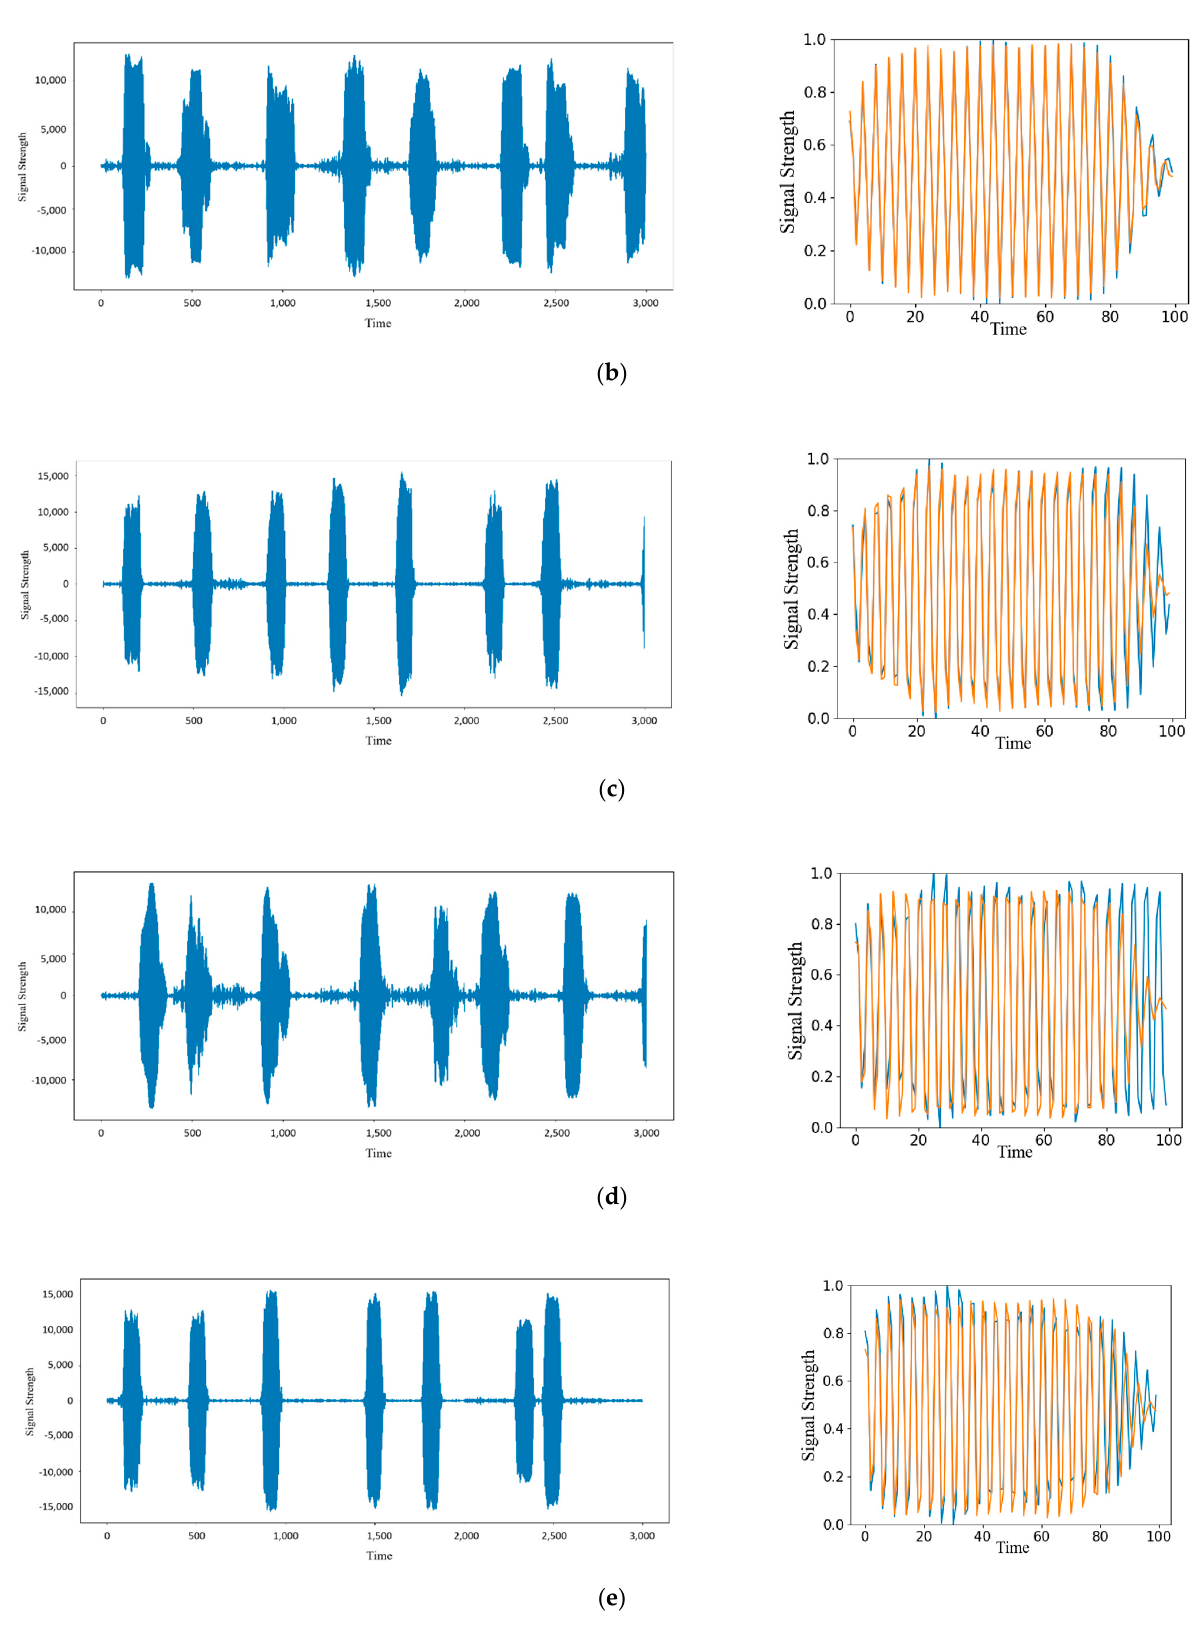
Figure 14. Reconstructed signals of different radar: ( a ) Signal 1 and its abnormal detection results; ( b ) Signal 2 and its abnormal detection results; ( c ) Signal 3 and its abnormal detection results; ( d ) Signal 4 and its abnormal detection results; ( e ) Signal 5 and its abnormal detection